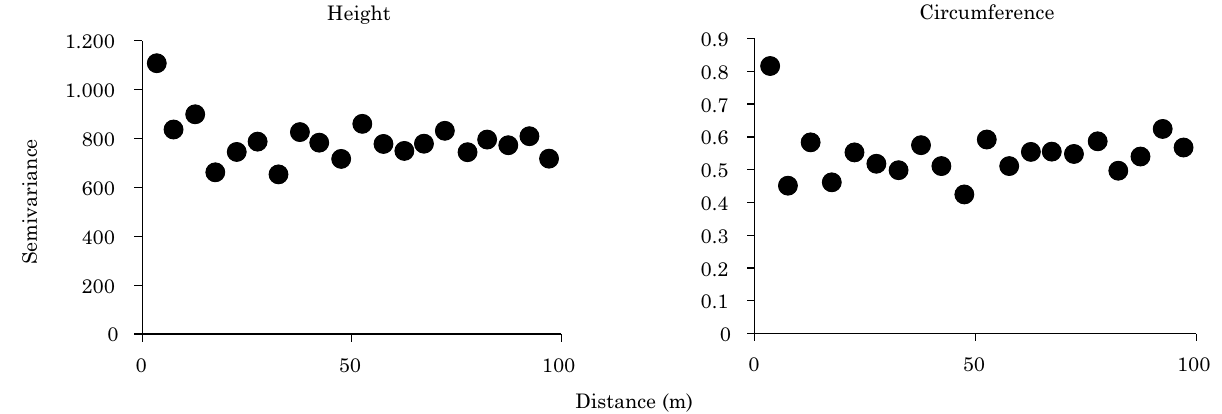
Figure 1. Semivariogram of termite nest circumference and height evaluated in Plot 1 from Pasture 1, on the Fazenda Campana, Rio Brilhante, MS.